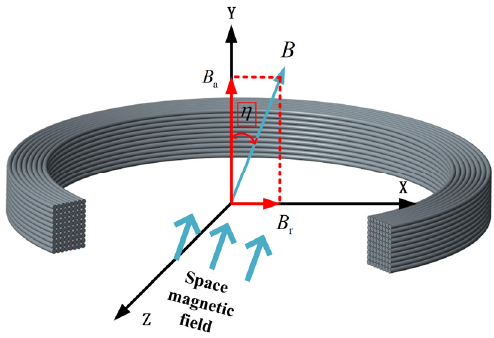
Figure 5. Schematic diagram of space magnetic field acting on fiber coil.